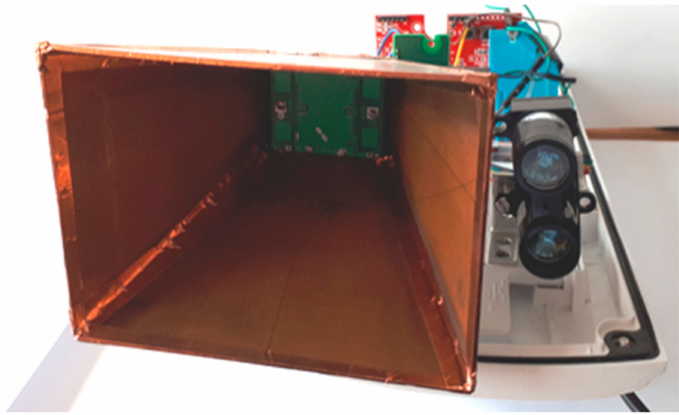
Figure 3. Housing of Microwave Doppler radar